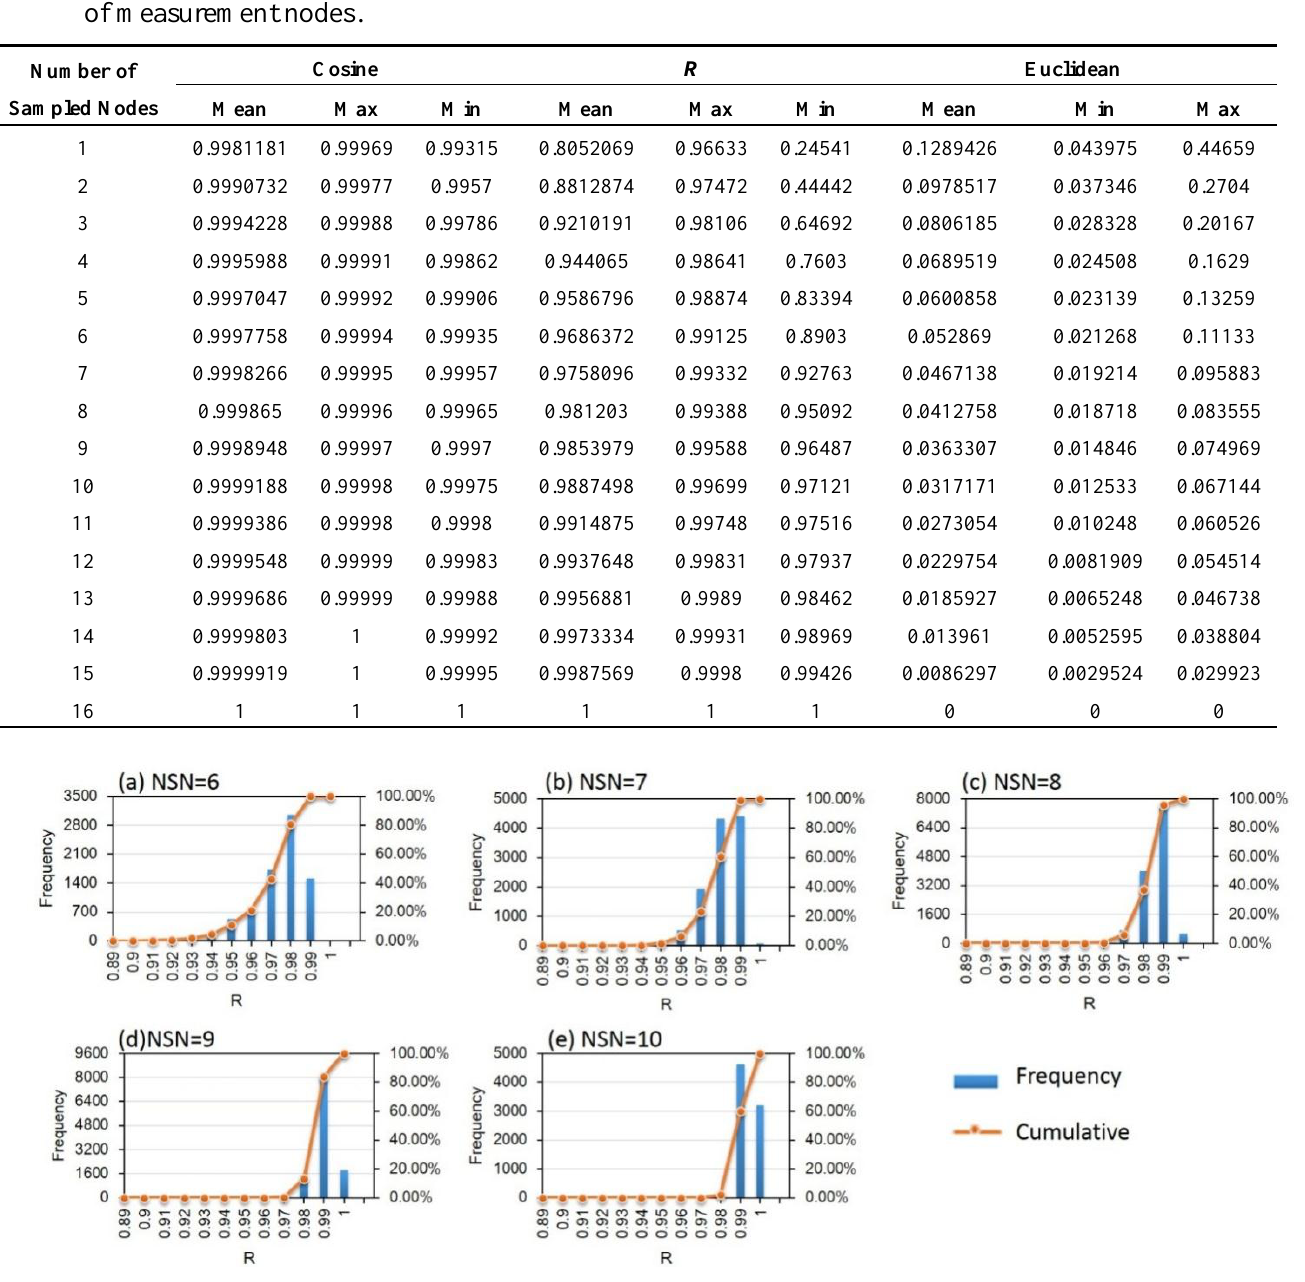
Figure 9. Frequency distribution histogram of number of sampled subsets and the cumulative frequency for R when NSN ranging from 6 to 10. ( a – e ) are the results when NSN are 6, 7, 8, 9, 10,